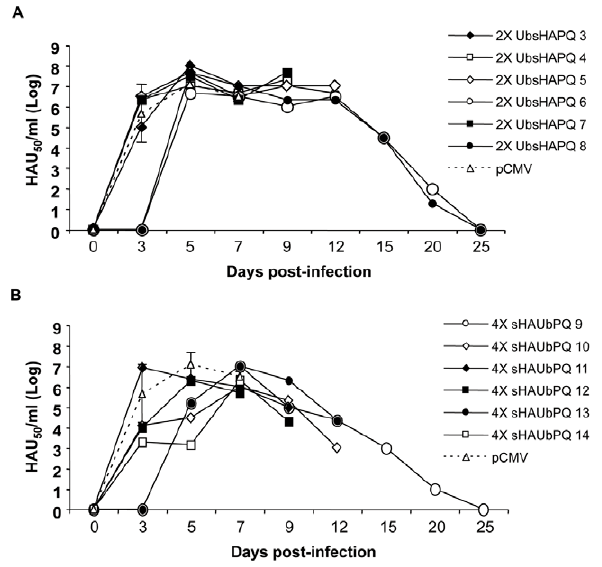
Figure 7. Surviving pigs show a rapid recovery from the ASFV- provoked leukopenia and a dramatic expansion of CD8 + T- cells. (A) Total nucleated-cell counting using whole blood samples taken at different days after ASFV challenge. (B) Number of CD8 + T-cells found at different times post-infection from these same blood samples after PBMC separation and CD8 + surface specific staining using the specific anti-CD8 monoclonal antibody. Values represented in both panels correspond to the average number of cell per mm 3 of pig blood. Standard deviation shown corresponds to those found within the pCMV-control group (dashed line) and those found for the three surviving pigs, pre-immunized pCMV-UbsHAPQ (solid line). No signif- icant differences were observed in the cell counts (nor in the total, nor the specific CD8 + T-cell counts), between non-surviving pigs, indepen- dent of the DNA plasmid